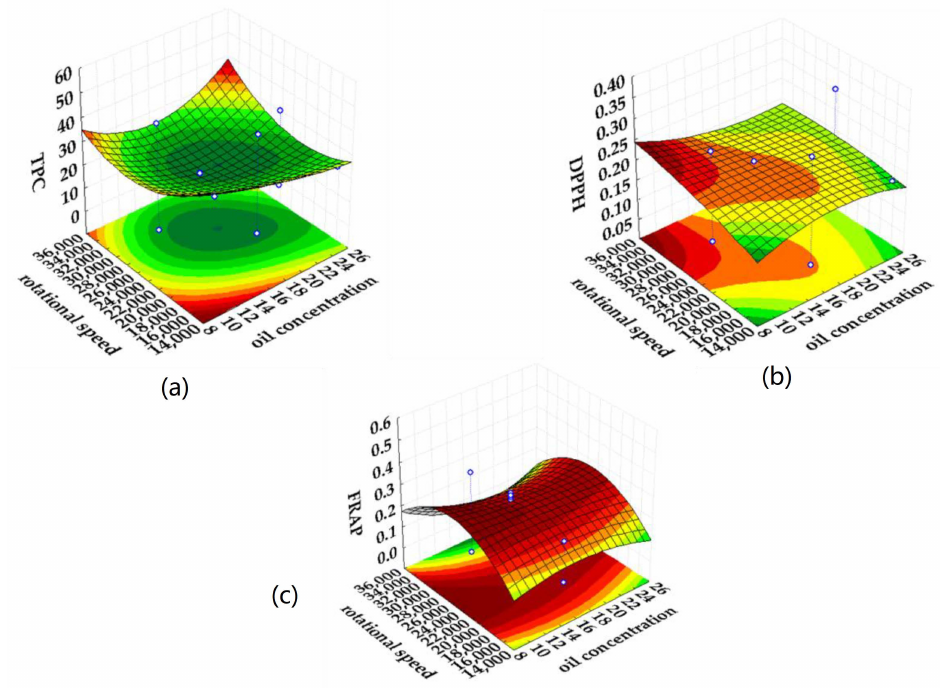
Figure 3. Response surfaces of the significant variables influencing the ( a ) the total polyphenolic content (TPC), antioxidant activity determined by ( b ) the DPPH and ( c ) the FRAP for the emulsified rosemary extract.